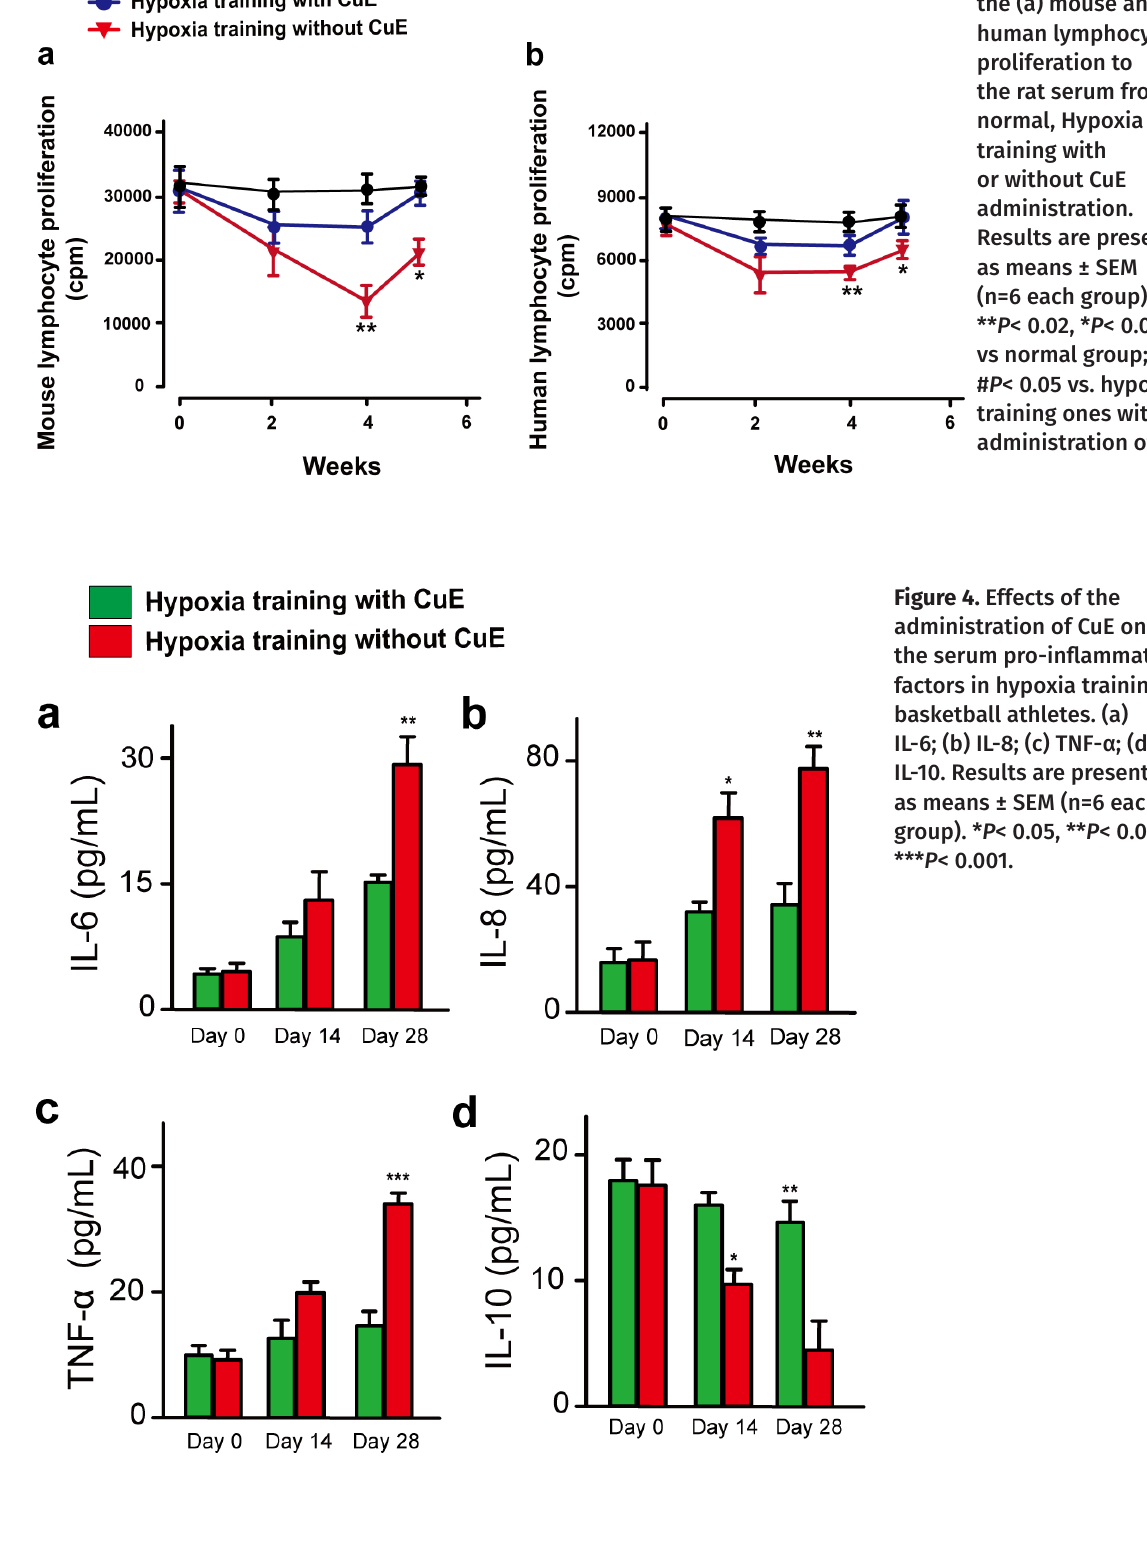
Figure 3. Response of